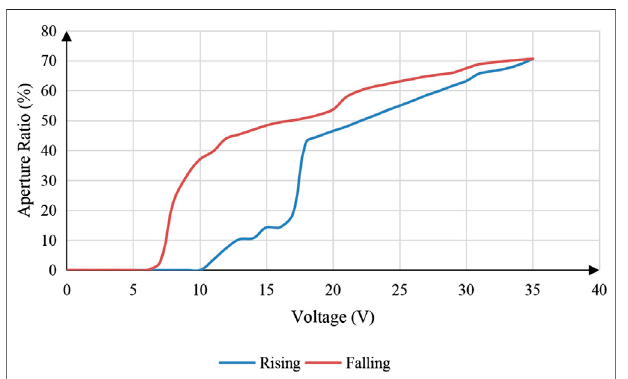
FIGURE 2 | The change of aperture ratio in the process of voltage rising and falling when an EWD is driven by a sine driving waveform.